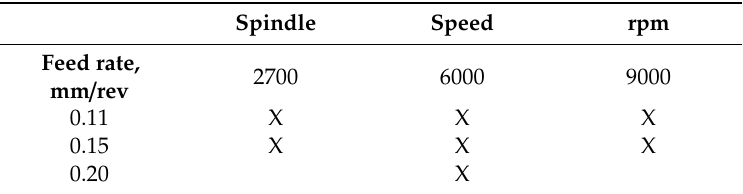
Table 1. Experimental drilling